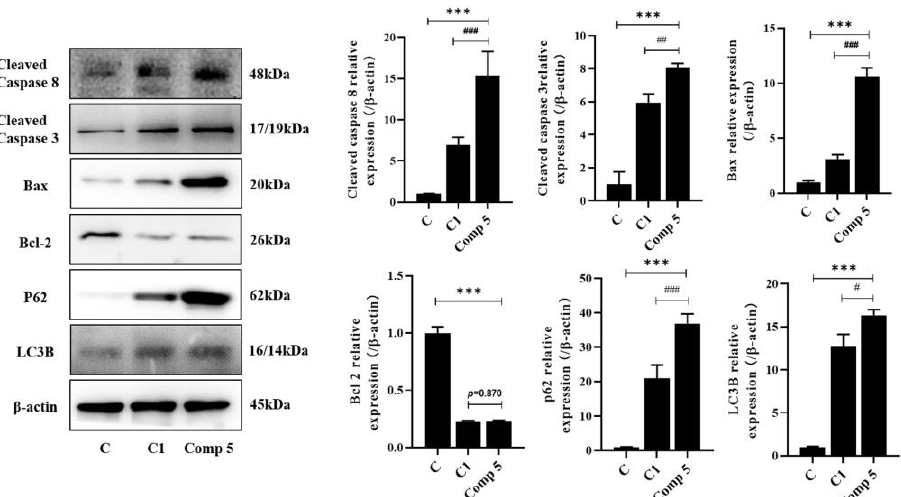
Figure 6. The effect of Compound 5 on HepG2 cells or HepG2 and RAW264.7 co-cultivation. C: HepG2 and RAW264.5 co-cultivations. C1: HepG2 cells were treated with 25 µ mol · L − 1 of 5 . Comp 5 : HepG2 and RAW264.5 co-cultivations were treated with 25 µ mol · L − 1 of 5 . Cells were treated by 5 for 48 h, and the expression of cleaved-caspase 3 and 8, LC3-B, Bax, Bcl-2, and p62 was detected by western blot. Data are expressed as the mean ± standard deviation. *** p < 0.001 vs. C group. # p < 0.05, ## p < 0.01, ### p < 0.001 vs. C1 group.